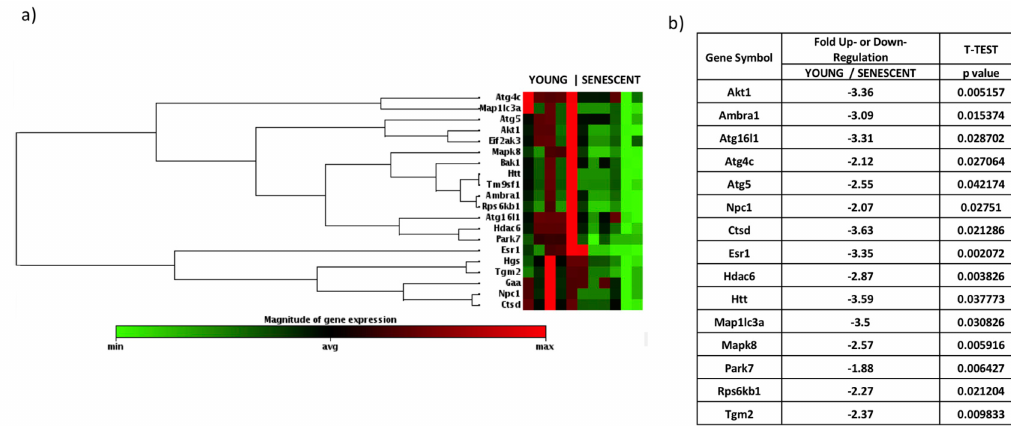
Figure 3. Di ff erentially expressed genes of the autophagy pathway comparing the young knee and senescent knee groups. ( a ) Heatmap of gene expressions and unsupervised hierarchical cluster analysis for genes of the autophagy pathway comparing young rats (3 weeks, N = 6) and senescent rats (25 months, N = 5). The values are expressed in log2. All data were normalized to the best housekeeping genes. Green = downregulated; red = upregulated. Magnitude of log2 (fold change): from − 1.84 to 1.84. ( b ) Fold changes of di ff erentially expressed genes. Gene expression was evaluated using the ∆∆ CT method, considering a fold change of > 1.5 and Student’s t-test with a p -value < 0.05 as criteria. Negative values indicate downregulation, and positive values indicate upregulation. Akt1: V-akt murine thymoma viral oncogene homolog 1; Ambra1: Autophagy / beclin 1 regulator 1; Atg16l1: ATG16 autophagy related 16-like 1 ( S. cerevisiae ); Atg4c: ATG4 autophagy-related 4 homolog C ( S. cerevisiae ); Atg5: autophagy-related 5 homolog ( S. cerevisiae ); Npc1: Cdig2 protein; Ctsd: cathepsin D; Esr1: estrogen receptor 1; Hdac6: histone deacetylase 6; Htt: huntingtin; Map1lc3a: microtubule-associated protein 1 light chain 3 alpha; Mapk8: mitogen-activated protein kinase 8; Park7: Parkinson’s disease (autosomal recessive, early onset) 7; Rps6kb1: ribosomal protein S6 kinase, polypeptide 1; Tgm2: Transglutaminase 2, C polypeptide. p -values were calculated on the bases of Student’s t-test of replicate values of 2ˆ (-delta CT) for each gene for the senescent and young